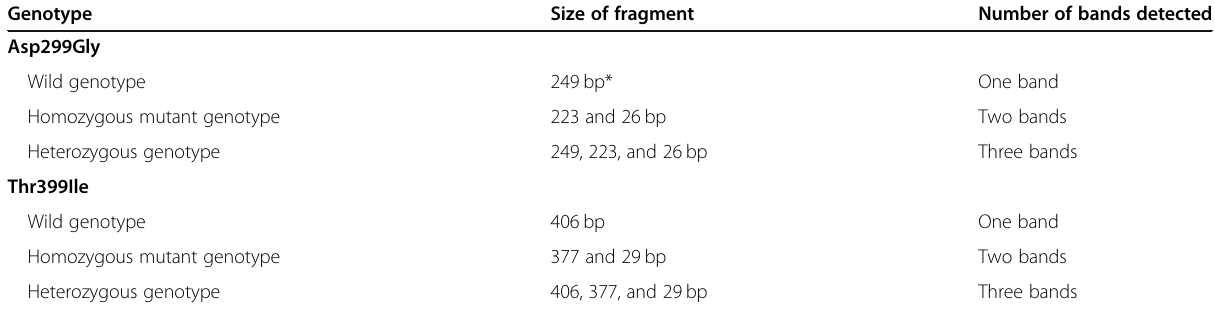
Table 1 Identified bands of Asp299Gly and Thr399Ile genotypes after trans-illumination by ultraviolet trans-illuminator Genotype